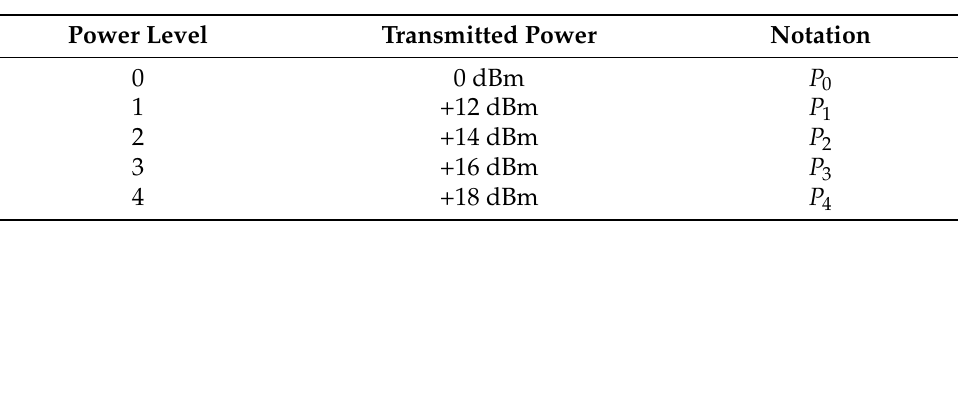
Figure 5. On-ankle path loss for different power levels at the data rate 9600 bps. The transmission rate is another variable in the experiment which may result in the discrepancy between the theoretical and practical path losses. To investigate the influences of data rate on the path loss between two ankles, the transmitted power is fixed at P 0 = 0 dBm, so that the path loss is equal to the RSSI (cf. Equation (5)). Figure 6 describes the relationship between the distance and the path loss when the transmission rate is varied. Similarly, the black left-pointing triangles and the red circles are the average values of 50,000 measured experimental path losses at the data rates of 9600 bps and 19,200 bps, respectively. The corresponding colored solid lines are the fitting curves for these two cases. The bottom blue line is the theoretical free space path loss. In theory, the path loss is influenced by distance and frequency only, while, in practice, according to Figure 6, there is also a dependence on the data rate. With an increment of distance, the difference between the two cases of 9600 bps and 19,200 bps increases gradually. Within the step length 0.6 m to 0.8 m of our interest, the discrepancy is around 2 dB. Therefore, the non-linearity due to the transmission rate may contribute to the total correction factor ∆ PL by about 2 dB, i.e., PL NonL ≈ 2 dB. Table 2. Transmitted power of different settings for XBee-PRO S2C RF